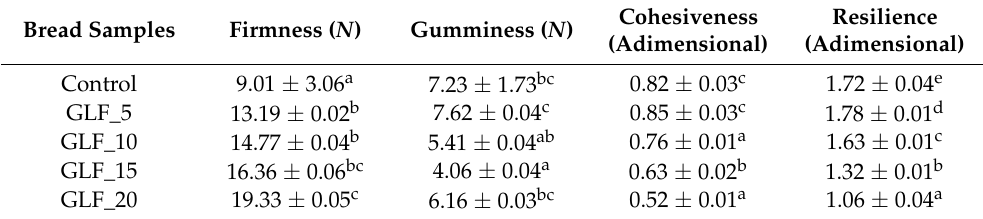
Table 6. Texture parameters of the bread samples with different levels of GLF additions. Bread Samples Firmness ( N ) Gumminess ( N )